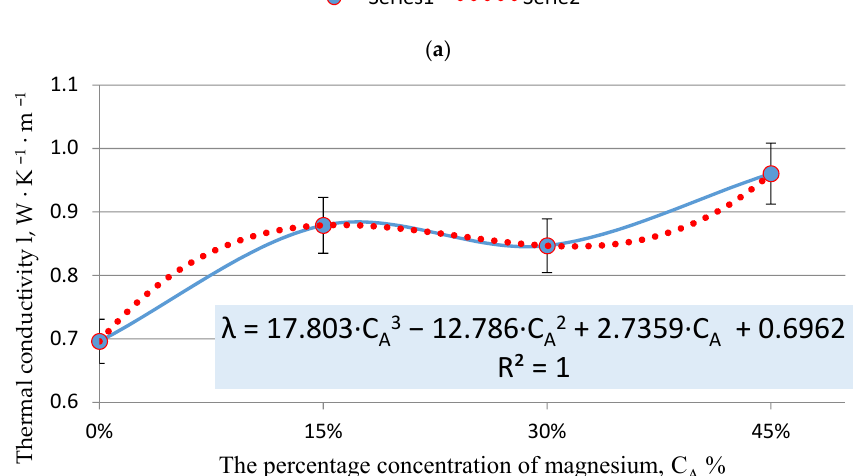
Table 5. Thermal conductivity test results for designs D, E and F.